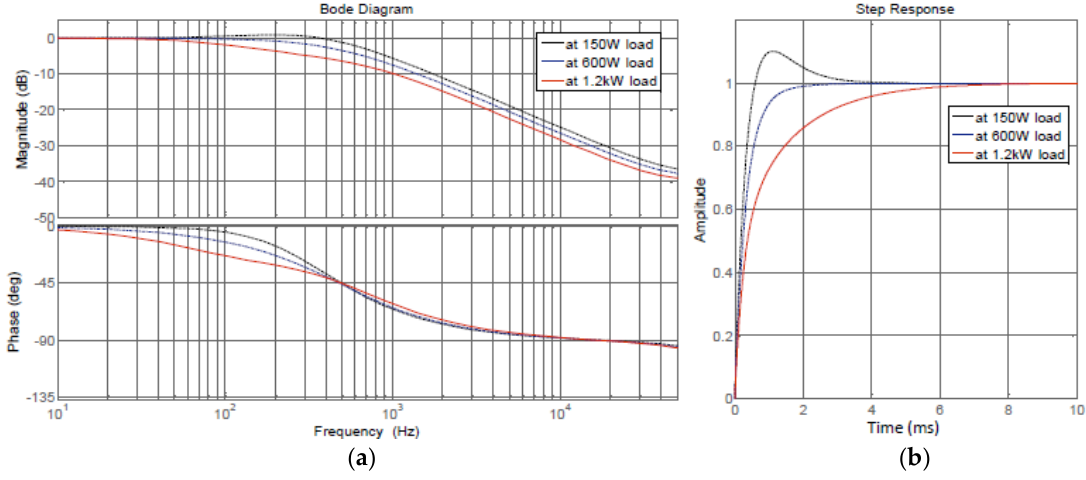
Figure 8. Dynamic response characterization of the converter (simulation results): closed-loop Bode plots ( a ) and system step response at different power levels ( b ).